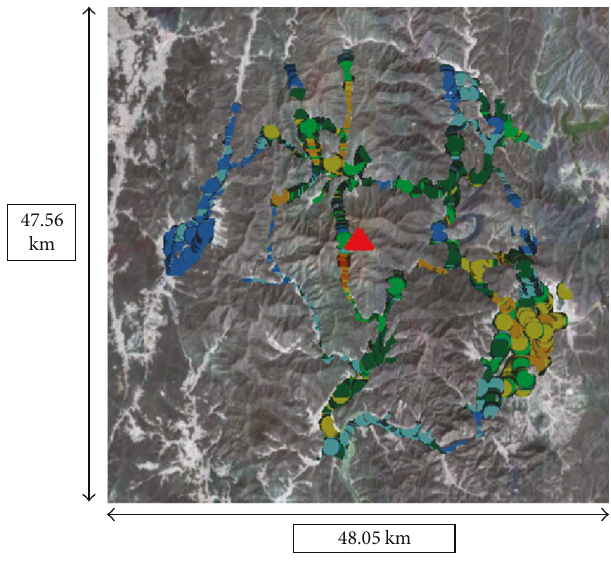
Figure 11: Measurements in Mt. Hwaak.